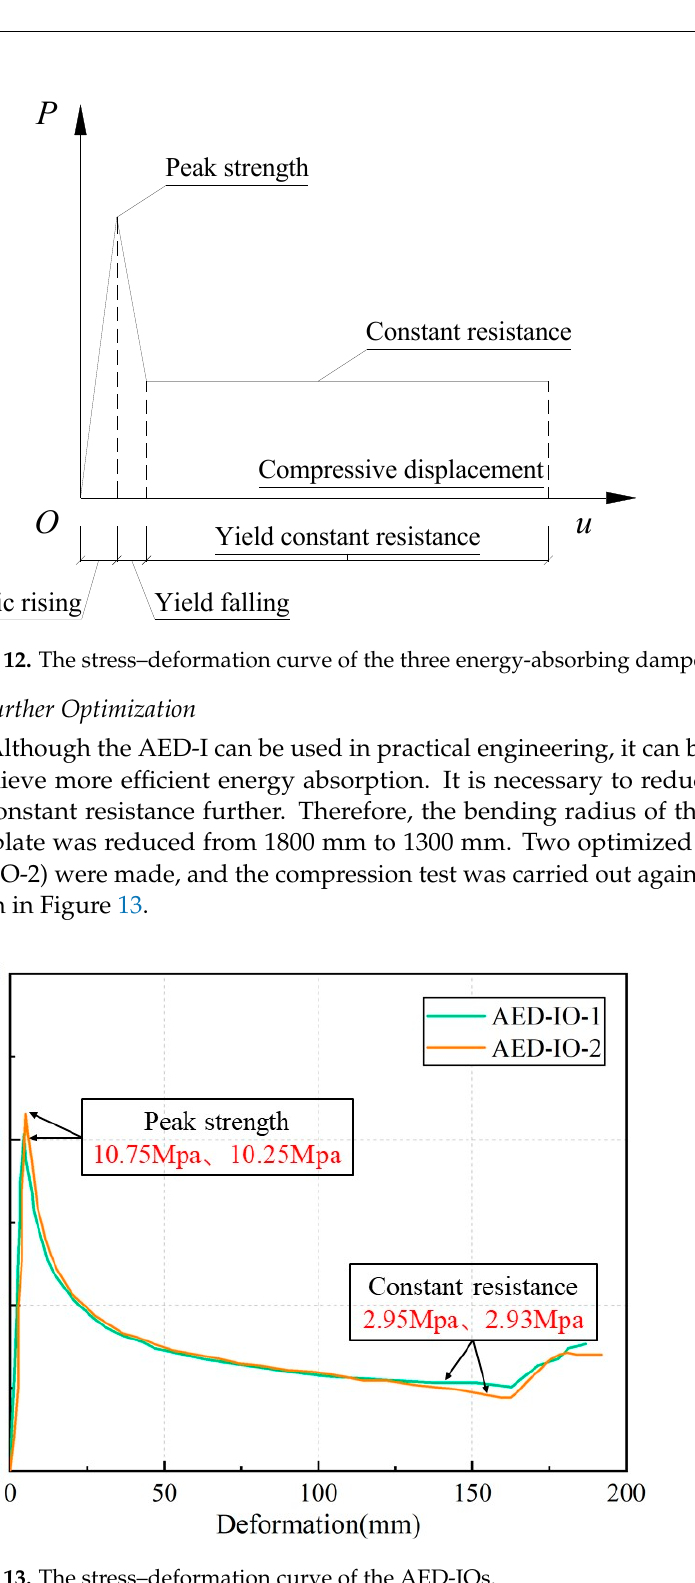
Table 3. Test results of the AED-IOs.